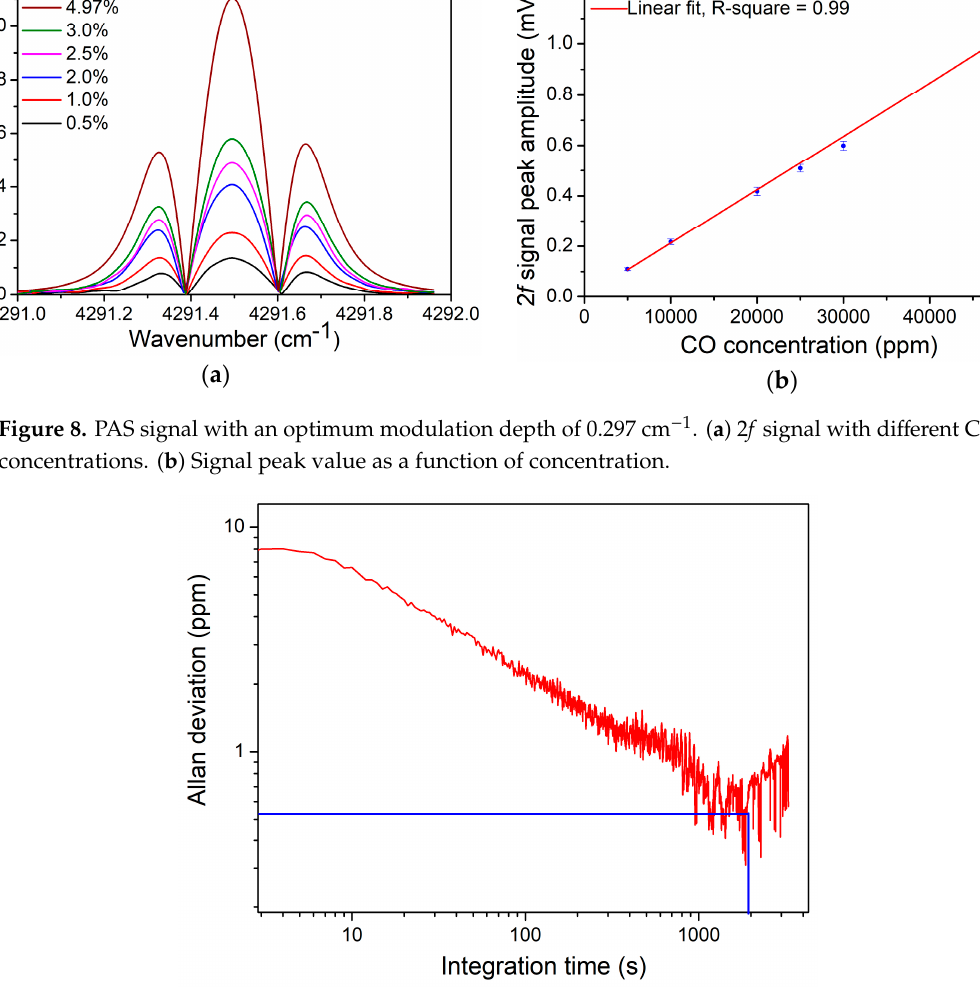
Figure 9. Allan deviation analysis for the PAS-based CO gas sensor.